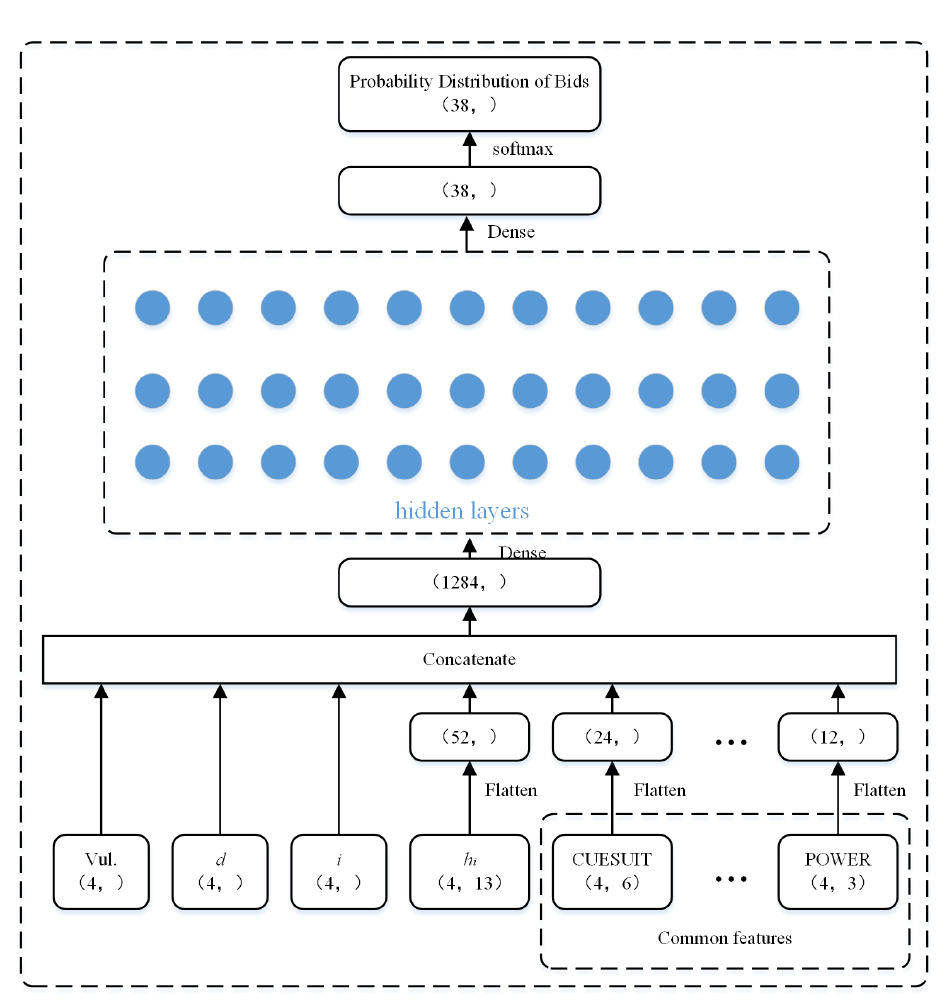
Figure 2. The structure for bid selection